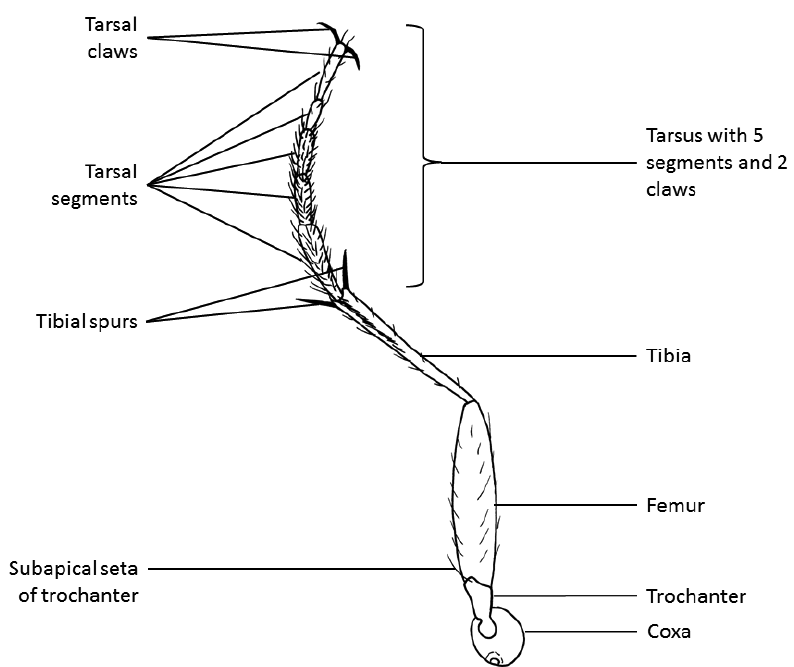
Figure 5. Leg of a tiger beetle and structures often used for identification. The prefixes pro-, meso- and meta- are used to indicate parts of the front, middle and hind legs, respectively. For example, metatibia refers to the tibia of hind leg and profemur to the femur of fore leg.